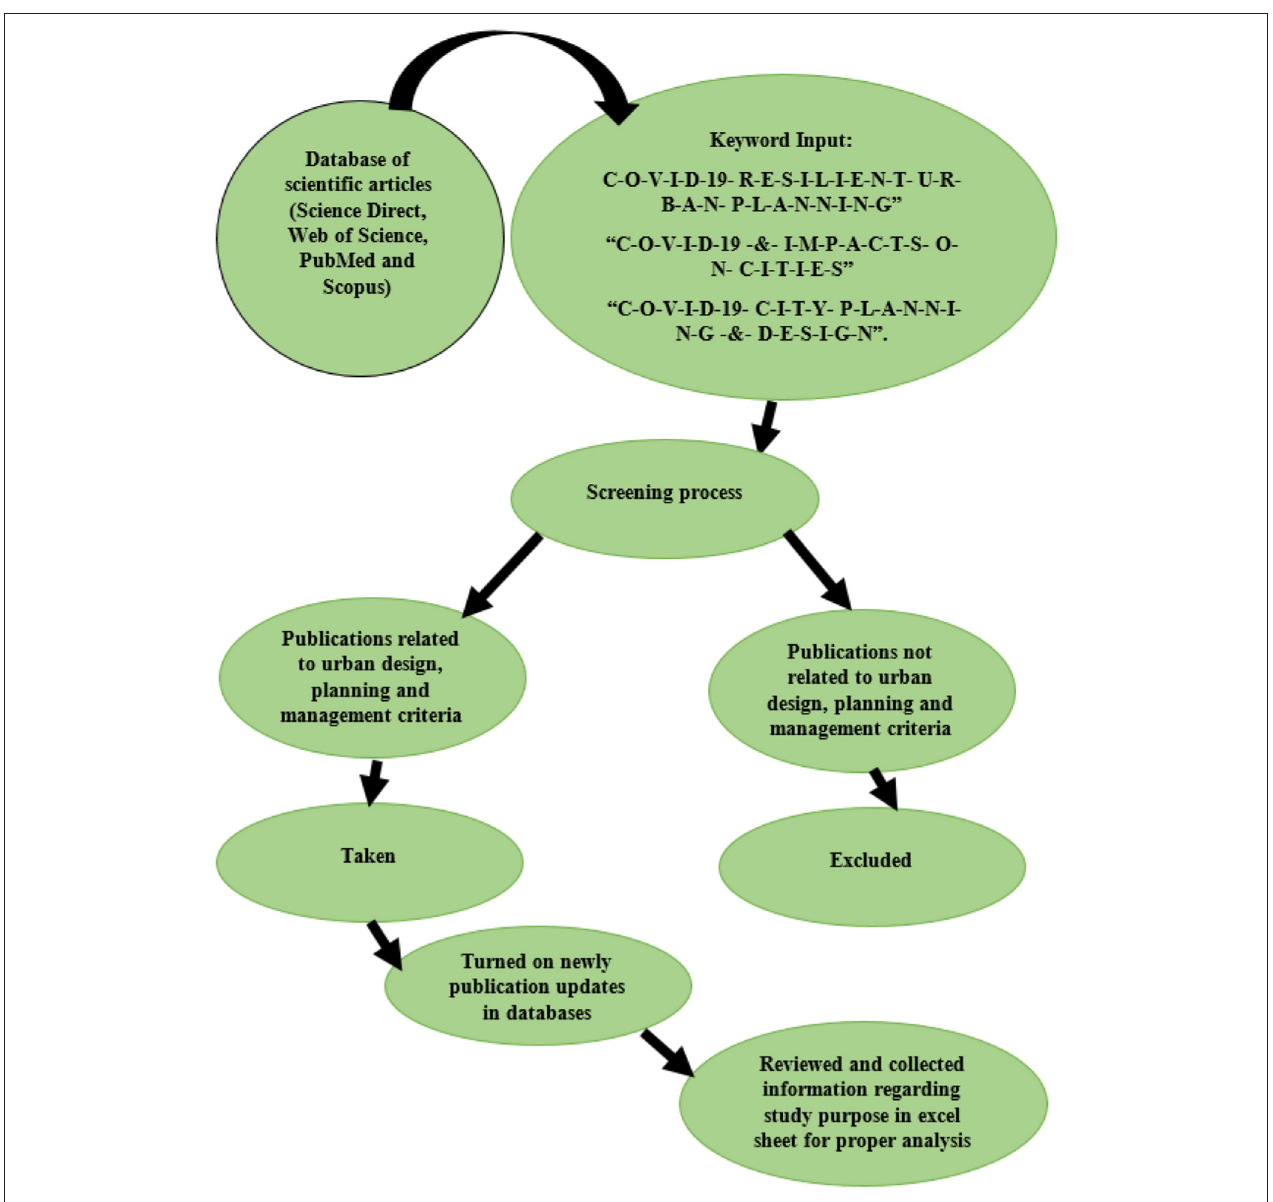
FIGURE 1 | Methodology of the